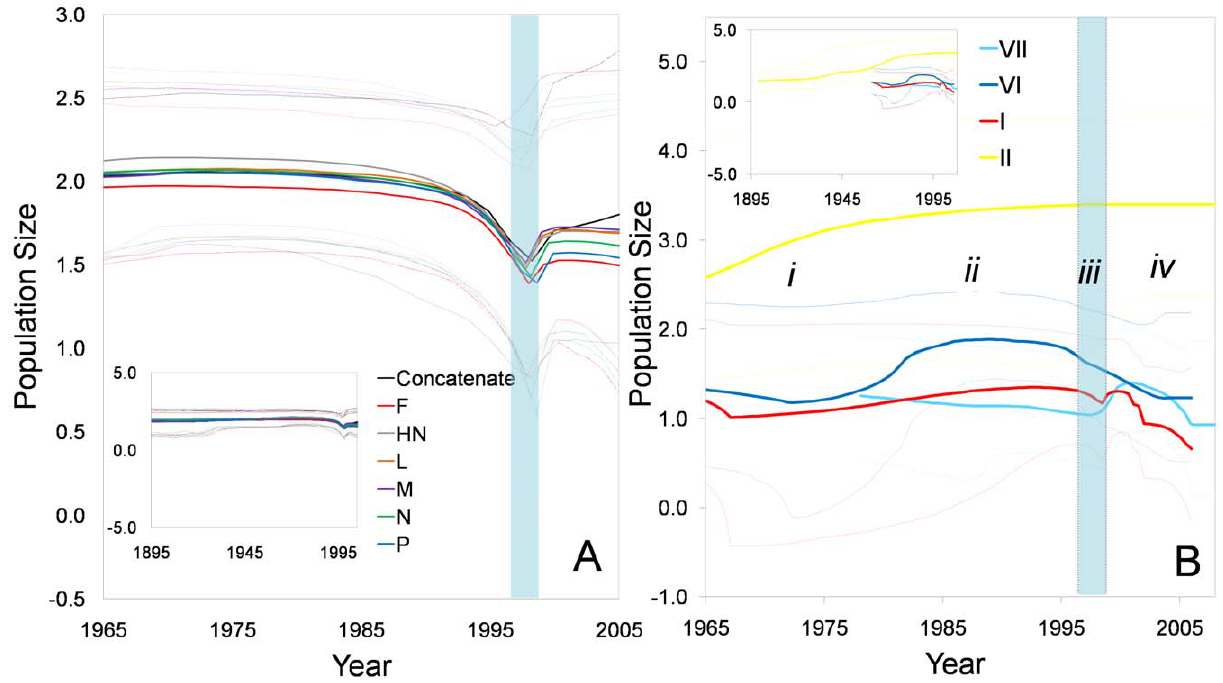
Figure 5. Bayesian skyline plots (BSP) depicting effective population size of class II aPMV-1 over time. Effective population size estimates are expressed on a logarithmic scale ( y axis). Solid lines denote the median estimates and the dotted lines give the 95% HPD intervals of the estimates. The shaded light blue region indicates a population bottleneck. BSP based on ( A ) individual genes and concatenated genome sequences. The figure highlights the interval from 1965–2005; the entire estimate is displayed in the inset. The dark blue, red, pink, blue, light green, light blue and green lines are the estimates based on the concatenated sequence, NP, P, M, F, HN and L genes, respectively; ( B ) individual genotypes (I, II, VI, and VII) using complete F gene sequence. Symbols i-iv represent four phases of aPMV-1 history (described in detail in text). Genotype I, II, VI and VII, are coded by red, yellow, dark blue, and light blue lines, respectively.